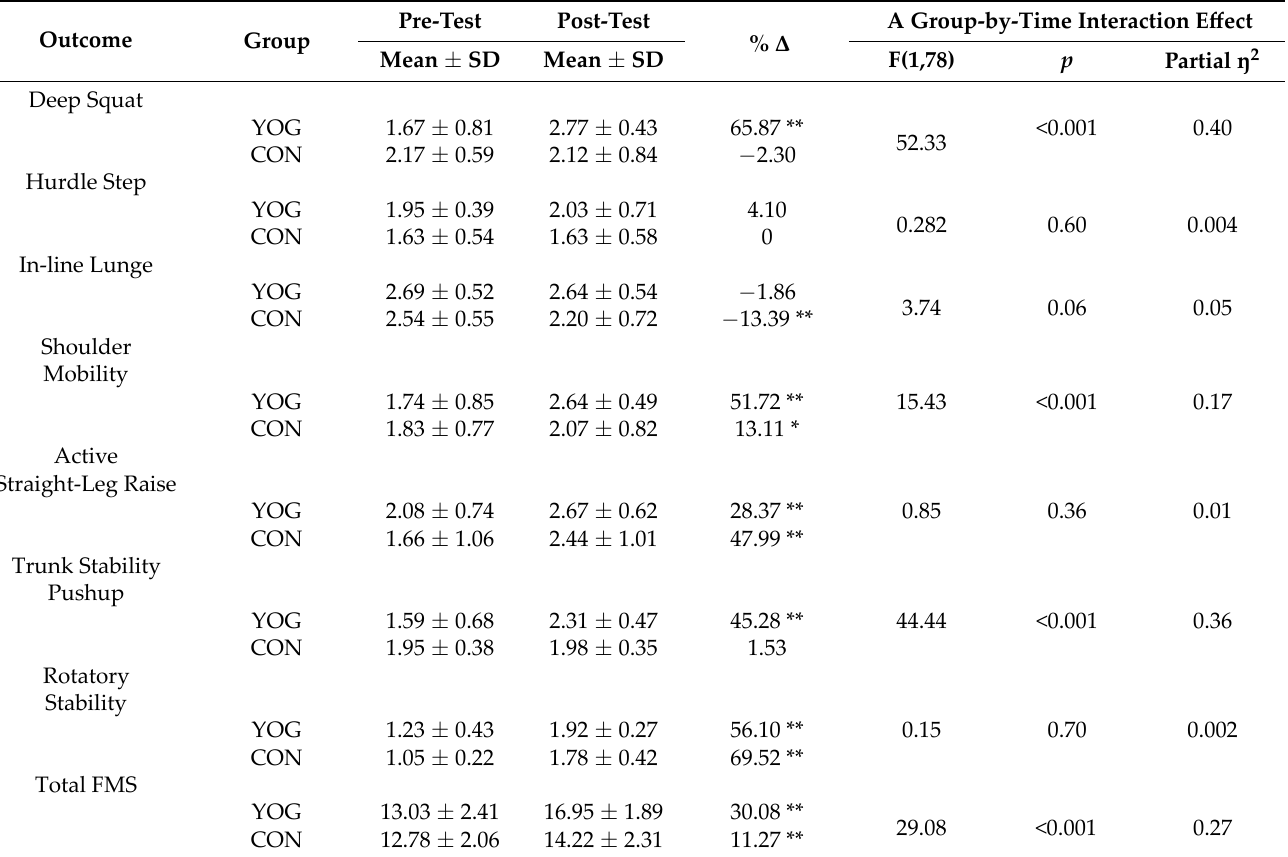
Table 4. FMS scores at pre‑and post‑test.